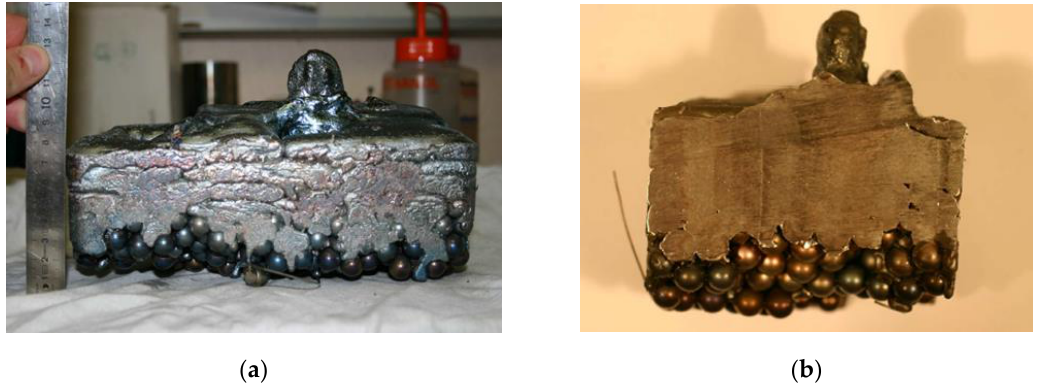
Figure 9. Pictures of the skull after melting. ( a ) view from the side. ( b ) transverse cut.